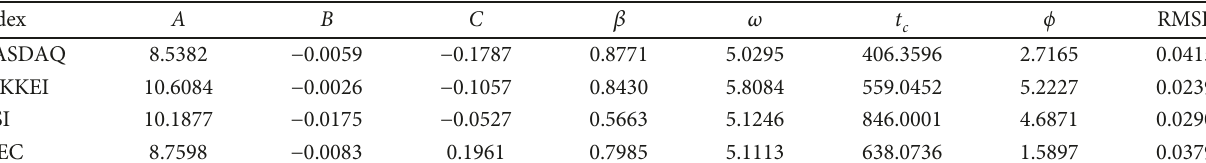
Table 4: LPPL parameters of the best fi t.